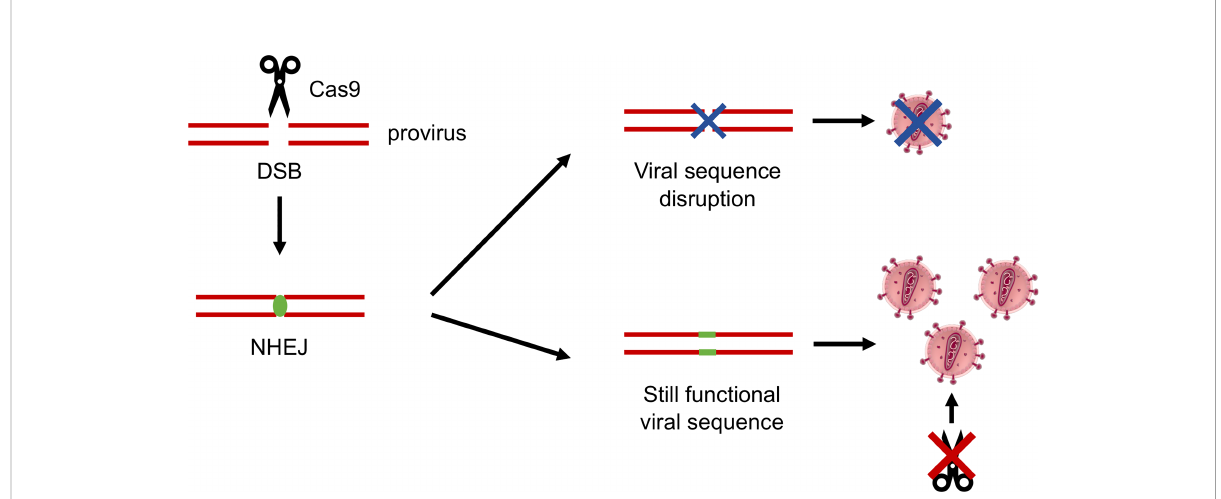
FIGURE 3 Schematic representation of the HIV-1 mechanisms of resistance to CRISPR-Cas9. The Cas9 nuclease operates a double-strand break (DSB) in the viral DNA sequence, which is repaired by the cellular non-homologous end joining (NHEJ) mechanisms of DNA repair. Indels introduced at the NHEJ site can effectively disrupt the virus, or can generate a sequence which is still functional, but in which the Cas9 recognition site is abolished, successfully generating CRISPR-Cas9 – resistant mutant